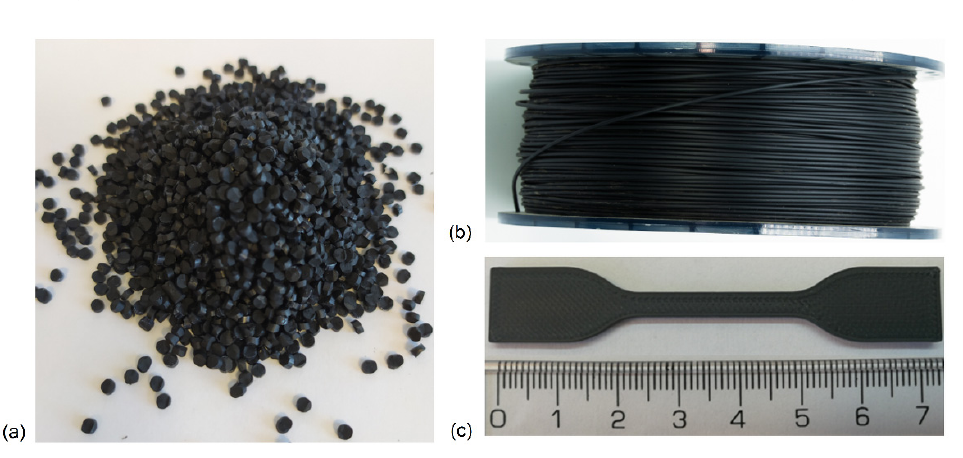
Figure 1. Pellets of a masterbatch containing 10 wt% rGO ( a ); HIPS filament with 0.5 wt% rGO content ( b ); tensile bar HIPS-0.5 ( c ).